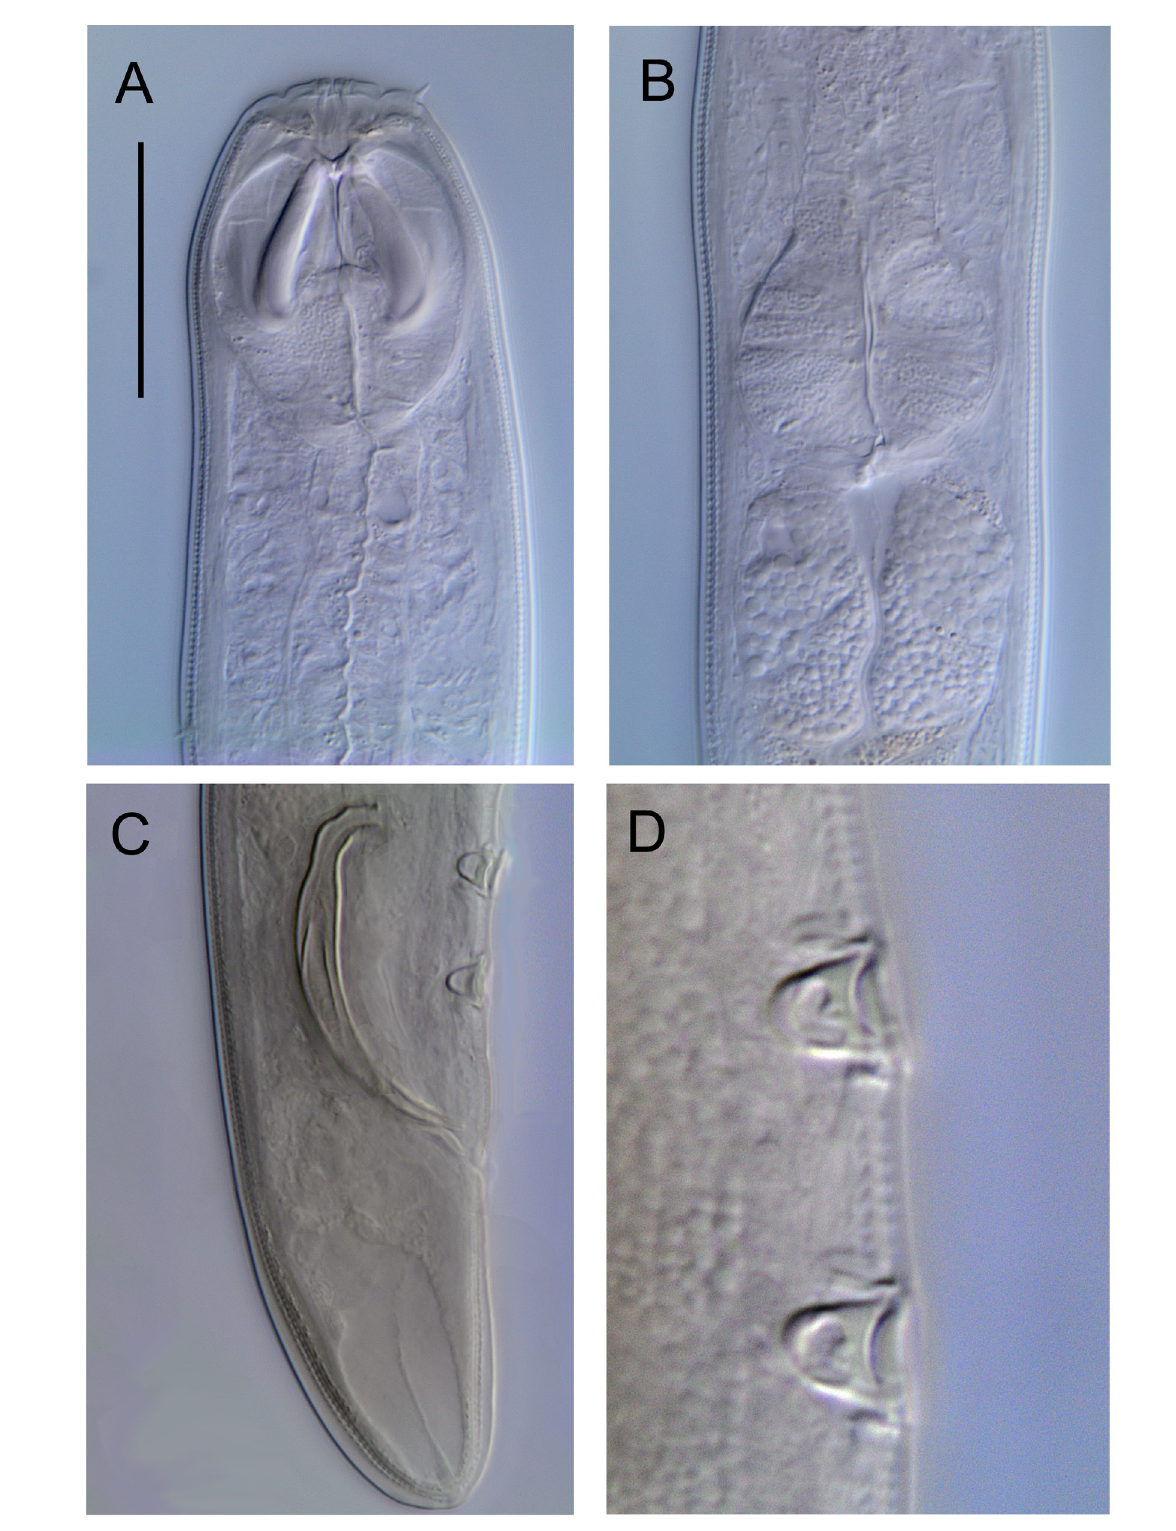
Fig. 7. Pseudocheironchus ingluviosus gen. et sp. nov. Light micrographs. A . Female head region showing buccal cavity and mandibles. B . Female posterior pharyngeal bulb and anterior portion of intestine. C . Male posterior body region showing right spicule and cup-shaped supplements. D . Detail of pre-cloacal supplements. Scale bar: A-C = 30 µ m; D = 10